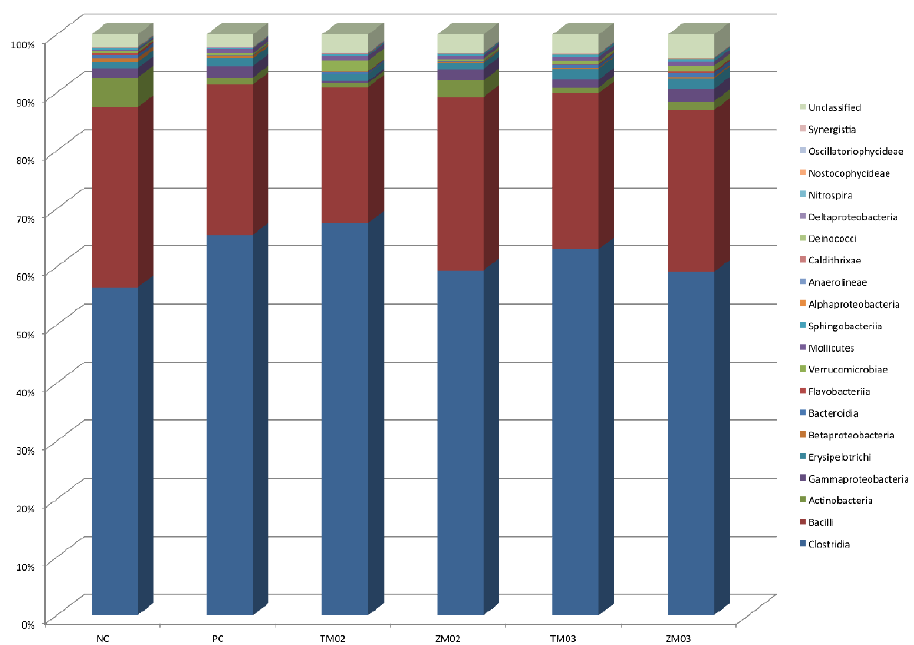
Figure 4. E ff ect of insect diet on chicken cecal microbiome composition at class-level. Legends refer to sample: PC—positive control (salinomycin, 60 ppm); NC—negative control (no additives); TM02—(0.2% T. molitor full-fat meal); ZM02—(0.2% Z. morio full-fat meal); TM03—(0.3% T. Figure 4. Effect of insect diet on chicken cecal microbiome composition at class - level. Legends refer to sample: PC— positive control (salinomycin, 60 ppm); NC — negative control (no additives); TM02 — (0.2% T. molitor full- fat meal); ZM02 — (0.2% Z. morio full- fat meal); TM03 — (0.3% T. molitor full-fat